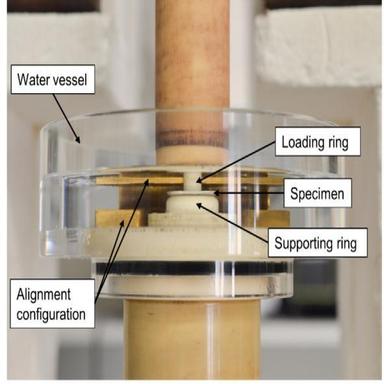
Test set-up of the ring-on-ring test.